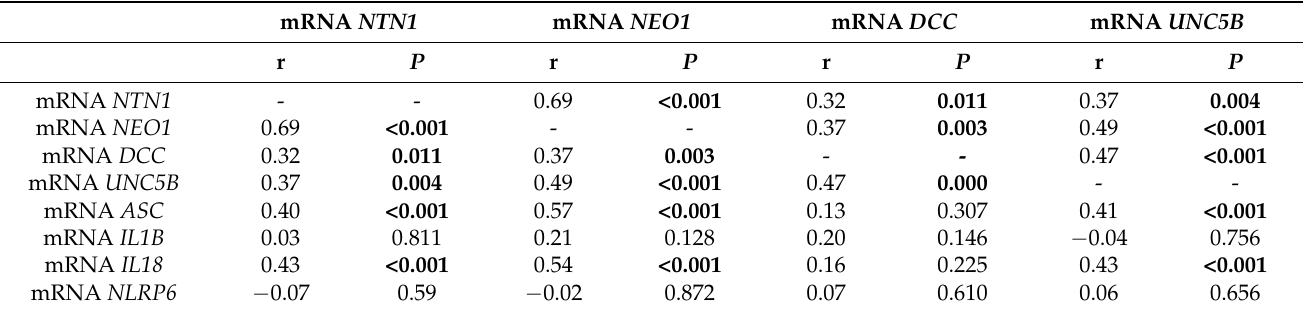
Figure 1. Gene expression levels of ( A ) netrin-1 ( NTN1 ), ( B ) neogenin-1 ( NEO1 ), ( C ) deleted in colorectal carcinomas ( DCC ), and ( D ) uncoordinated-5 homolog family member B ( UNC5B ) in visceral adipose tissue (VAT) from normal weight volunteers (NW) without (n = 6–9) and with (n = 14–16) colon cancer (CC) and patients with obesity (OB) without CC (n = 34–37) and with CC (n = 9–12). Bars represent the mean ± SEM. Differences between groups were analysed by two-way ANCOVA. Table 2. Analysis of the correlation between gene expression levels of NTN1 , its receptors and inflammation-related genes in visceral adipose